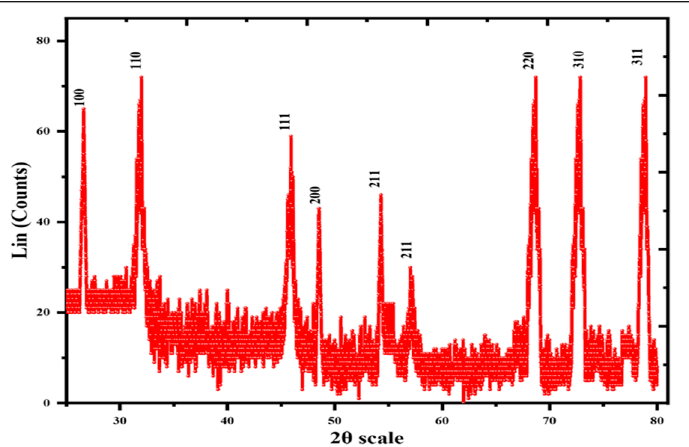
Figure 3. XRD spectra of Ag 2 ONPs developed by P . alsinaefolia . Table 1. (2 thetas) value and Bragg peak of P . alsinaefolia Ag 2 ONPs.